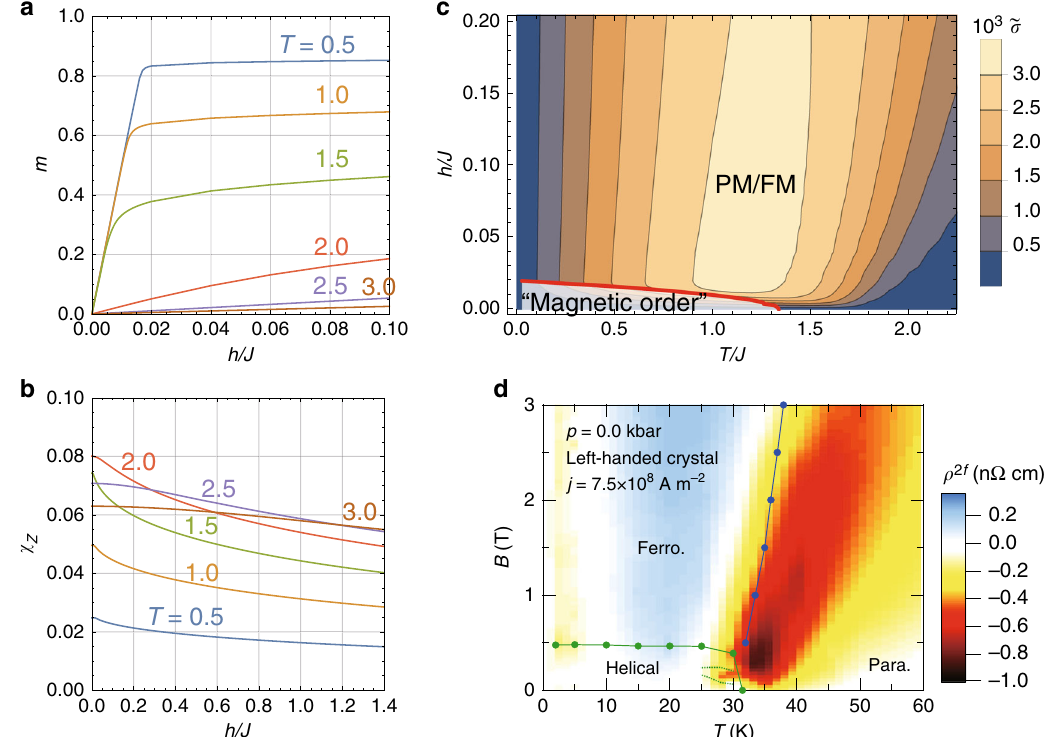
Fig. 2 Magnetic and transport properties of a three-dimensional chiral magnet. The magnetic- fi eld dependence of a magnetization M and b vector spin chirality χ z for different temperature T . c is the contour plot of ~ σ ¼ M χ z . The results are for D / J = 0.2. The red line is the phase boundary between the ordered and paramagnetic (PM/FM) phases, which is determined by λ + D 2 /(4 J ) > − 10 − 4 . See Method section for details. d The contour plot of second harmonic resistivity ρ 2 f ( ∝ σ (2) ). Reproduced from ref. 24